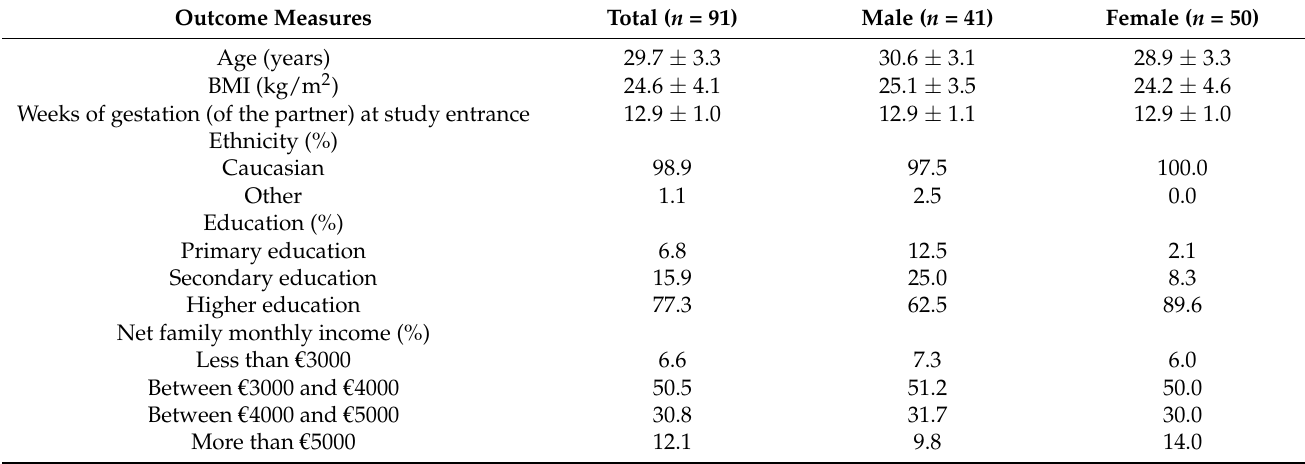
Table 1. Sample characteristics (mean ± SD,